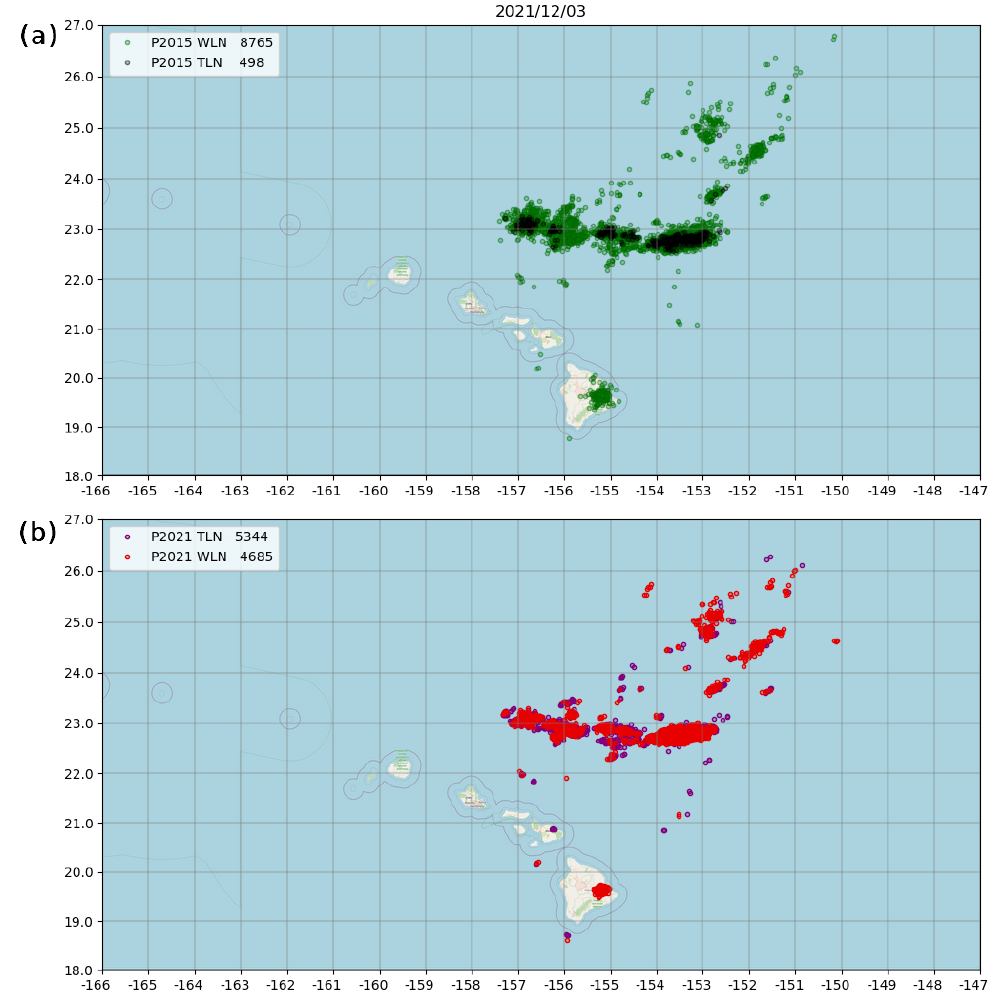
Figure 5. Locations of lightning in Hawaii for one case study. ( a ) ENTLN (black circles) and WWLLN (green circles) locations from P2015; ( b ) ENTLN (purple circles) and WWLLN (red circles) locations from